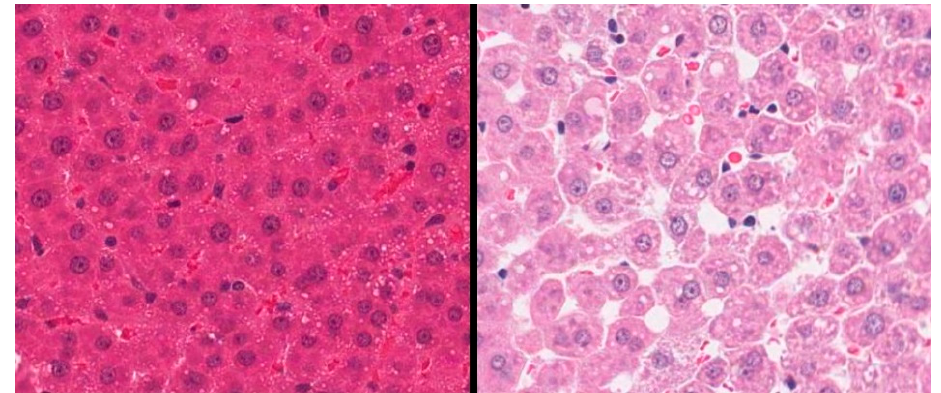
Figure 1. Validation of a Sprague-Dawley (SD) rat model of alcohol-induced hepatic injury on histopathologic examinations. The number and volume of fat globules were increased in ( right ) the SD rats ingesting 30% ethanol as compared with ( left ) those ingesting water without ethanol treatment (Hematoxylin & eosin, ×